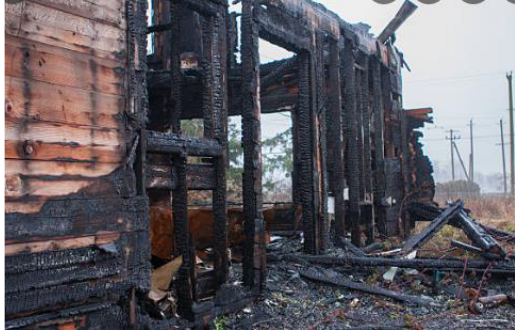
Figure 7. Wood fire